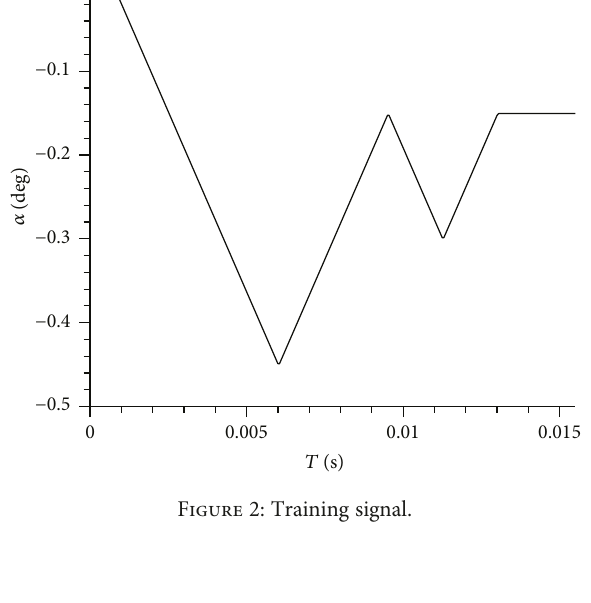
Figure 2: Training signal.